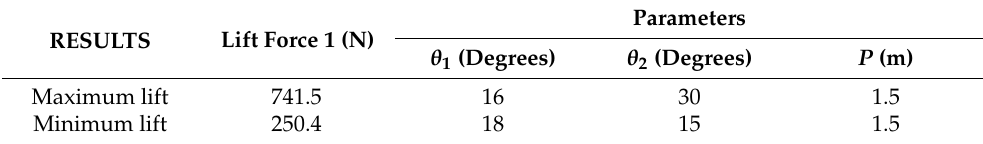
Table 3. Maximum and minimum values of the parameters for case I.